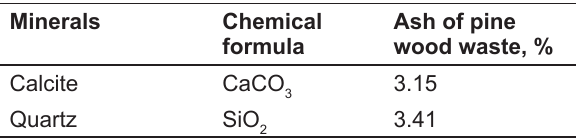
Table 5. The yield of most of the minerals determined in